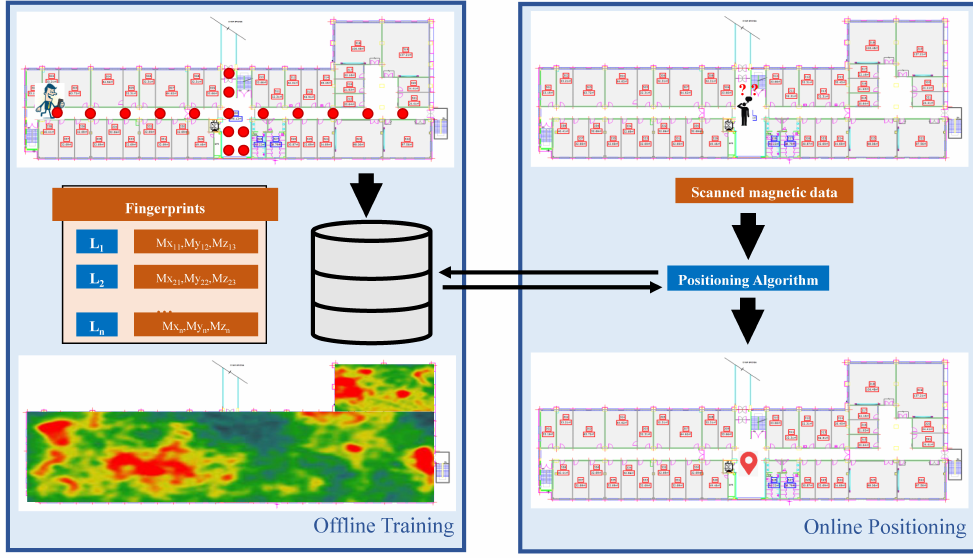
Figure 8. The architecture of a magnetic localization